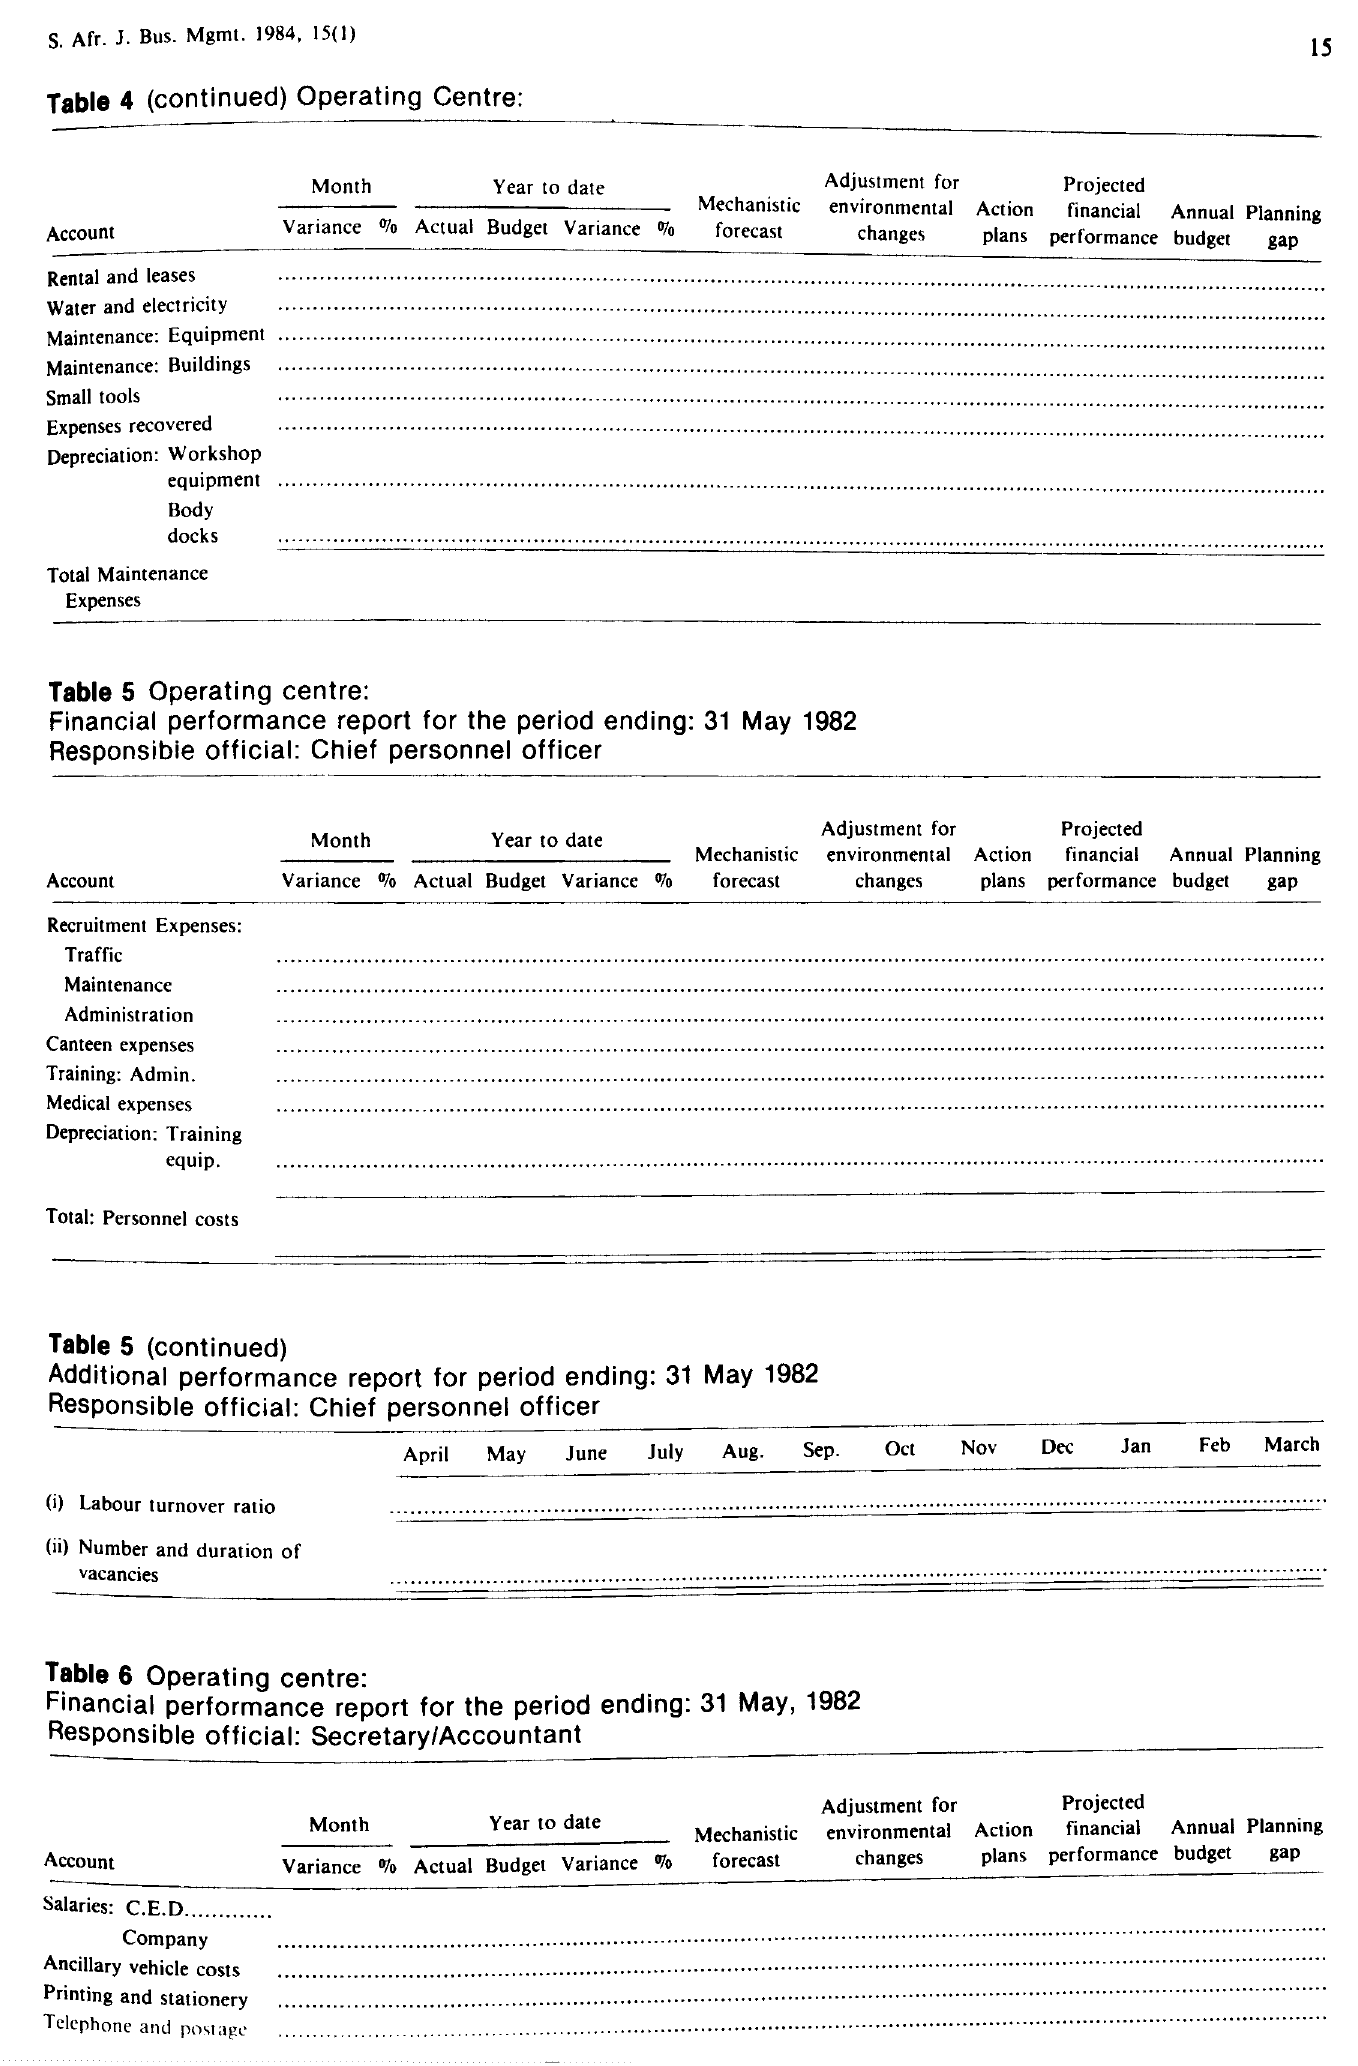
Table 5 Operating centre: Financial performance report for the period ending: 31 May 1982